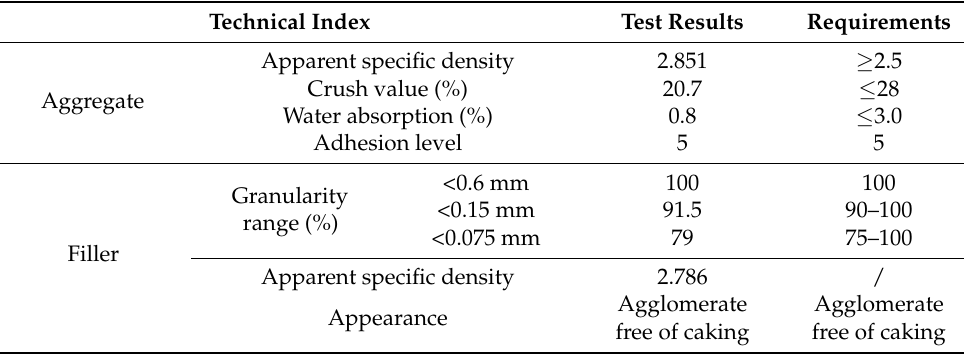
Table 3. The basic properties of the aggregate and filler.